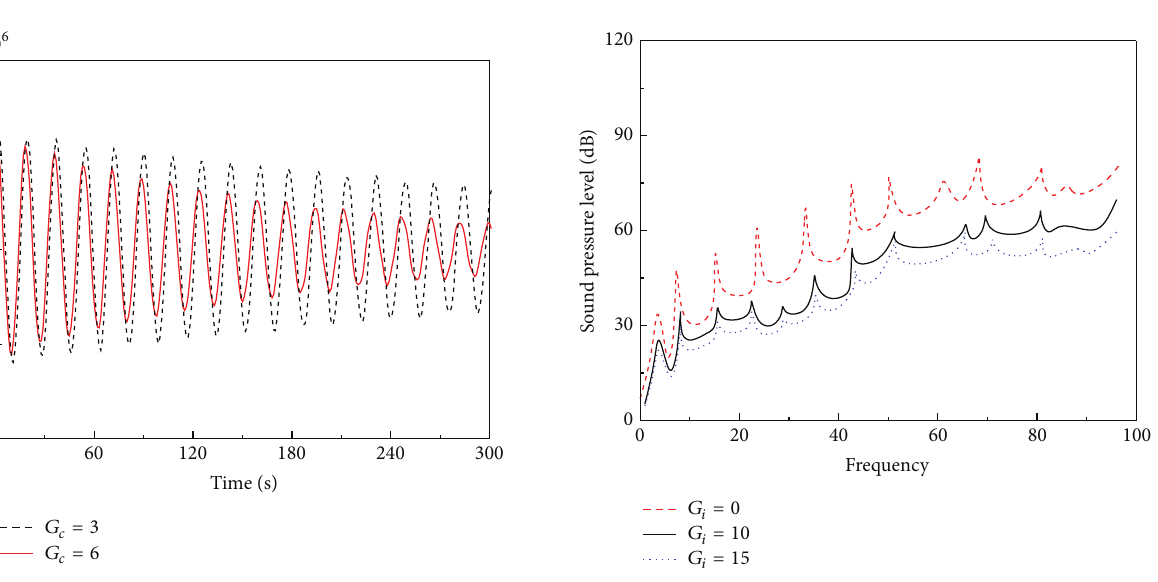
Figure 23: Effect of control gain on acoustic response of the underwater